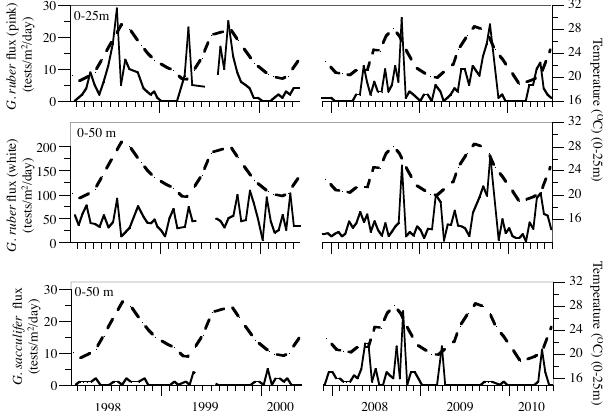
Figure 5. Temporal changes in surface-dwelling planktonic foraminifera fluxes in the 1500m trap with changes in sea surface temperature (0–25m) shown in the dashed black line for reference. The approximate depth habitat (Anand et al., 2003) is shown in fig-